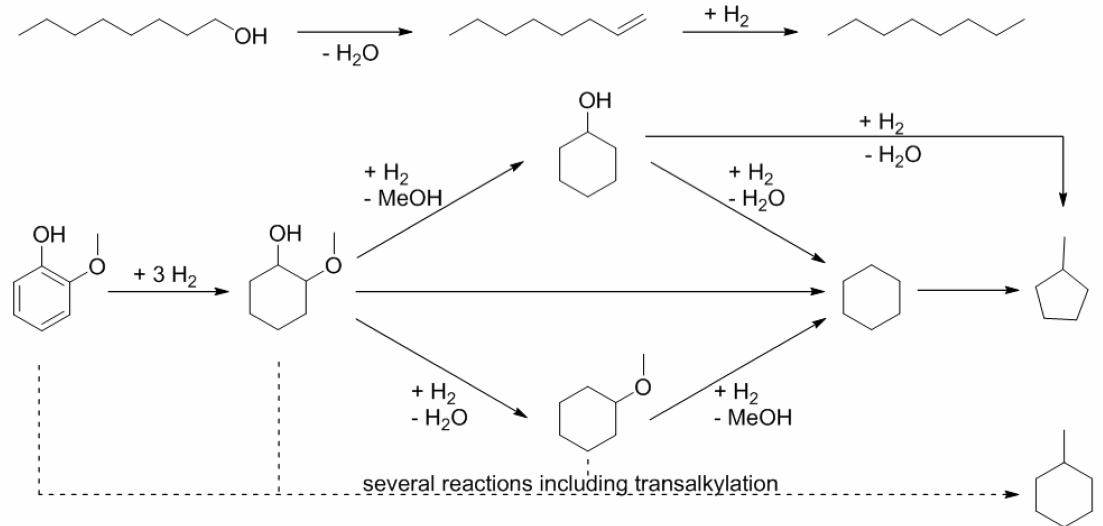
Figure 5. Activity of 1 wt. % Pt/H-MFI-90 in the hydrodeoxygenation of guaiacol ( a ) and 1-octanol ( b ) as a function of the temperature (conditions: 0.3 mL/min 5% GUA in GUA = guaiacol, m = methyl, mx = methoxy, c =